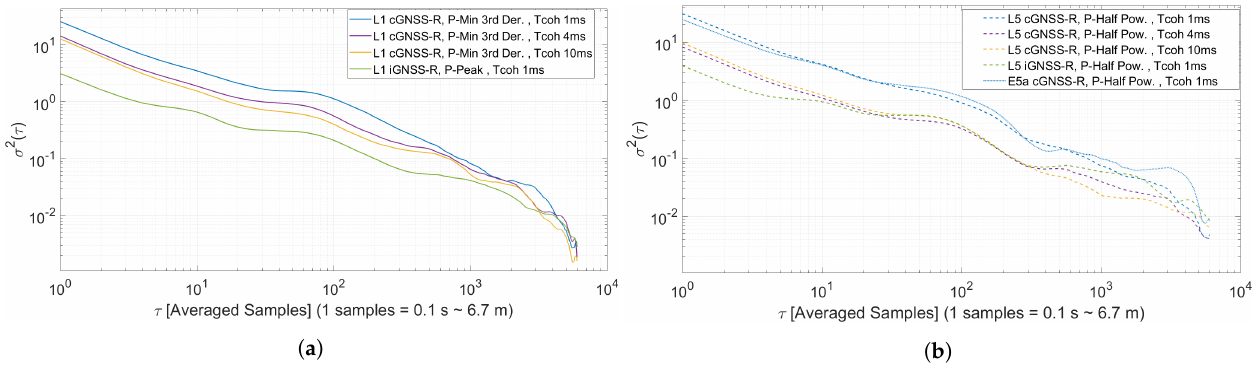
Figure 14. Allan variance computed for ( a ) L1 and ( b ) L5 and E5a for the computed altimetric methods and coherent integration